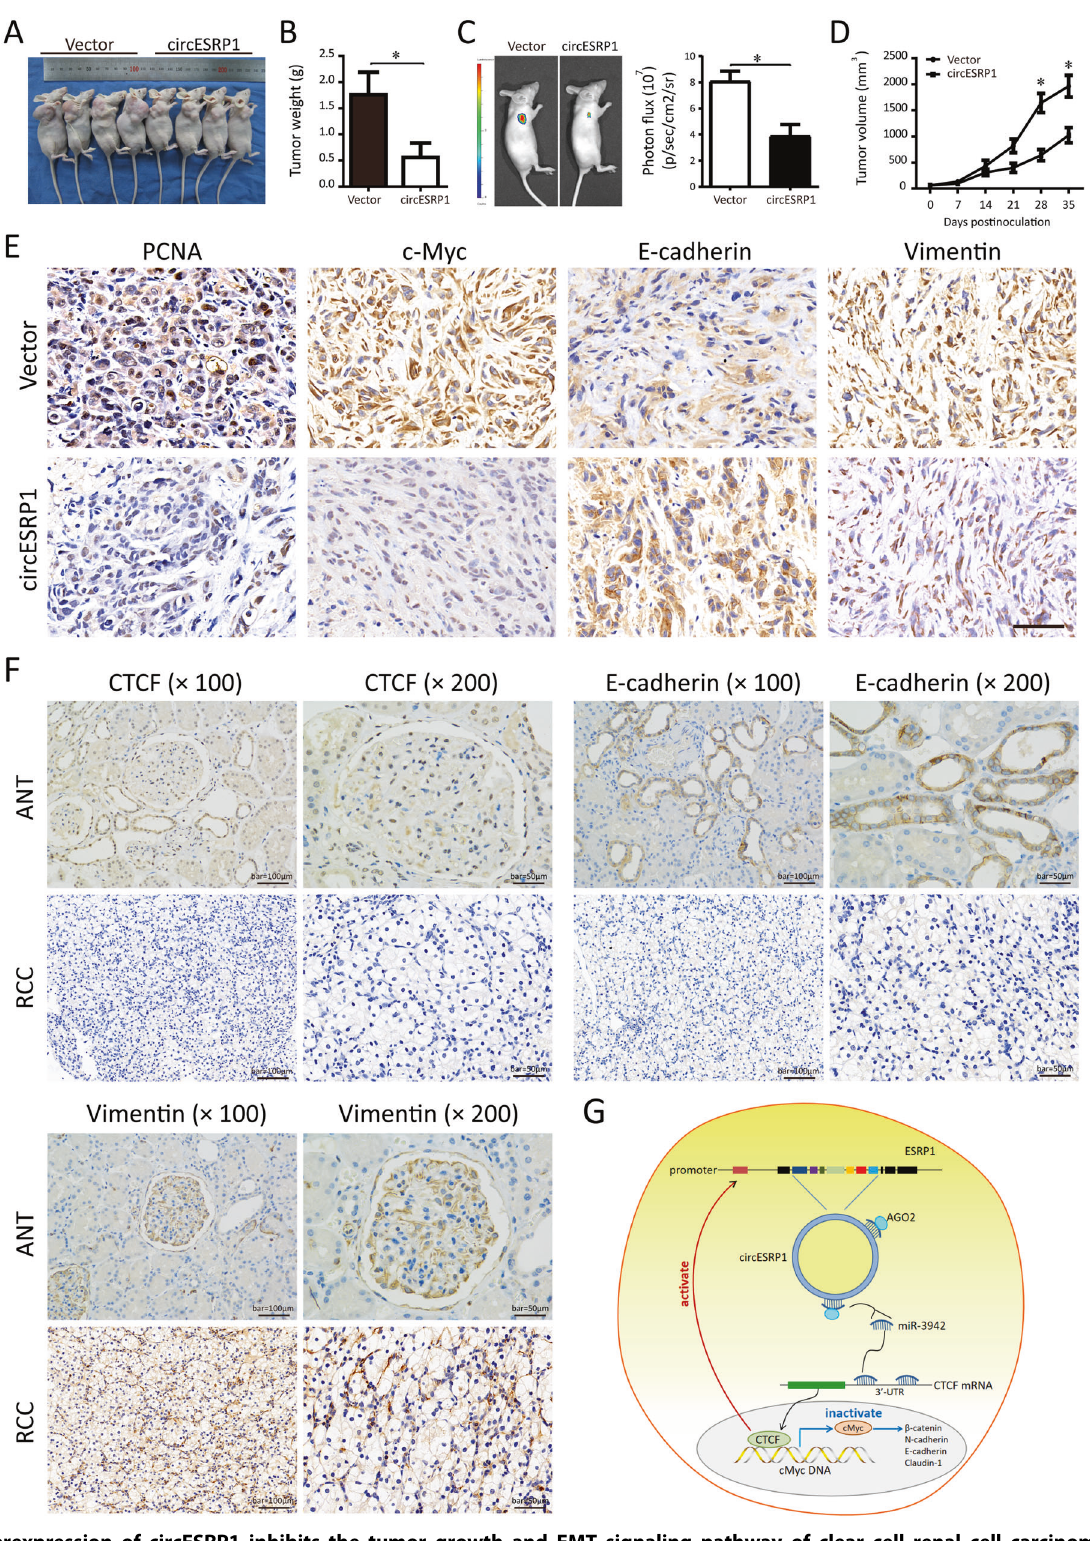
Fig. 8 Overexpression of circESRP1 inhibits the tumor growth and EMT signaling pathway of clear cell renal cell carcinoma (ccRCC) in vivo. A Overexpressed circESRP1 ACHN cells were injected subcutaneously to detect in vivo effect of circESRP1. B The tumor weight in circESRP1 overexpressed and control group. C Representative bioluminescence images of mice bearing ACHN cells were obtained. D Effect of circESRP1 expression level on ccRCC tumor volume in xenograft tumor mice. E Immunohistochemical staining of the tumor tissues showed that circESRP1 overexpression inhibited the tumor phenotypes of RCC. Bar = 50 μ m. F Immunohistochemical staining for CTCF, E-cadherin, and Vimentin in ccRCC tissues and adjacent non-tumor tissues was shown. G A Schematic Diagram of circESRP1/miR-3942/CTCF feedback loop in ccRCC cells EMT. * p < 0.05; ** p < 0.01.